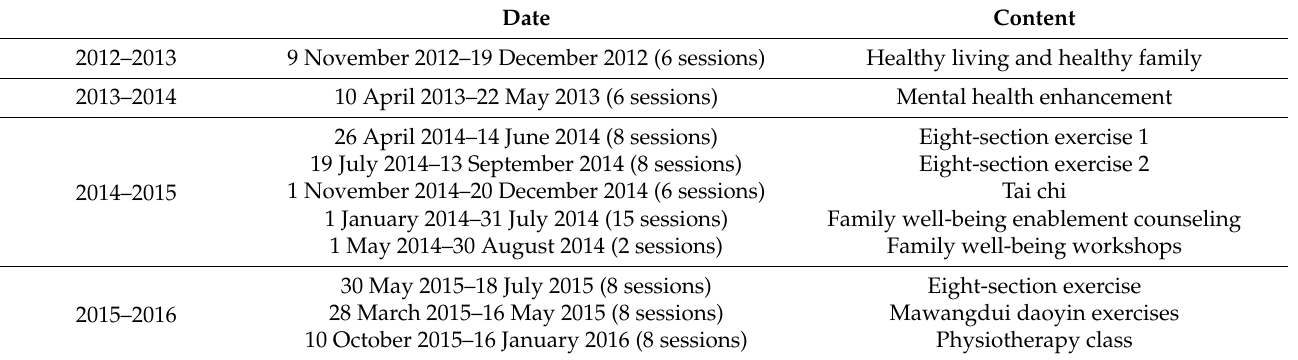
Table A2. Self-care enablement